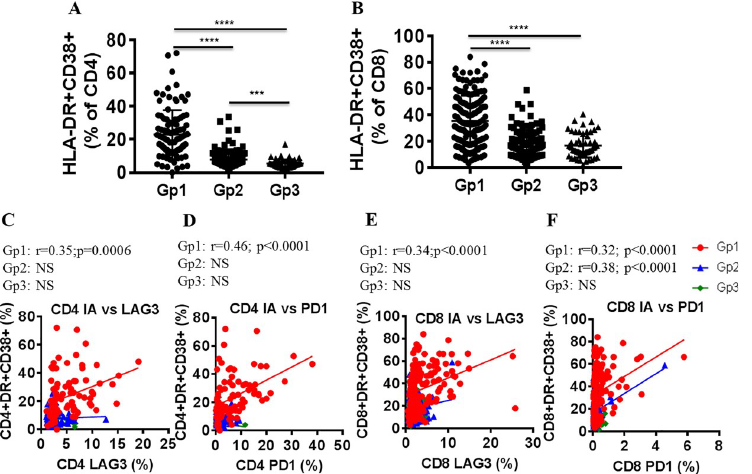
Fig 3. LAG-3 and PD1 expression on CD4 and CD8 T cells correlate with T cell immune activation in ART na ï ve groups. Immune activation on CD4 and CD8 T cells was measured based on the co-expression of HLA-DR and CD38 by flow cytometry. Frequencies of HLA-DR+CD38+ expressing A), CD4 and B), CD8 T cells are shown. Linear regression analysis shows correlation between CD4 T cell immune activation with C), LAG-3+ and D), PD1+ CD4 T cells and of CD8 T cell immune activation with E), LAG-3+ and F), PD1+ CD8 T cells in ART na ï ve (Gp1, red circles), virologically suppressed (Gp2, blue circles) and healthy control (Gp3, green circles) groups. Pearson correlation was performed based on data distribution; a p value of < 0.05 was considered as significant.